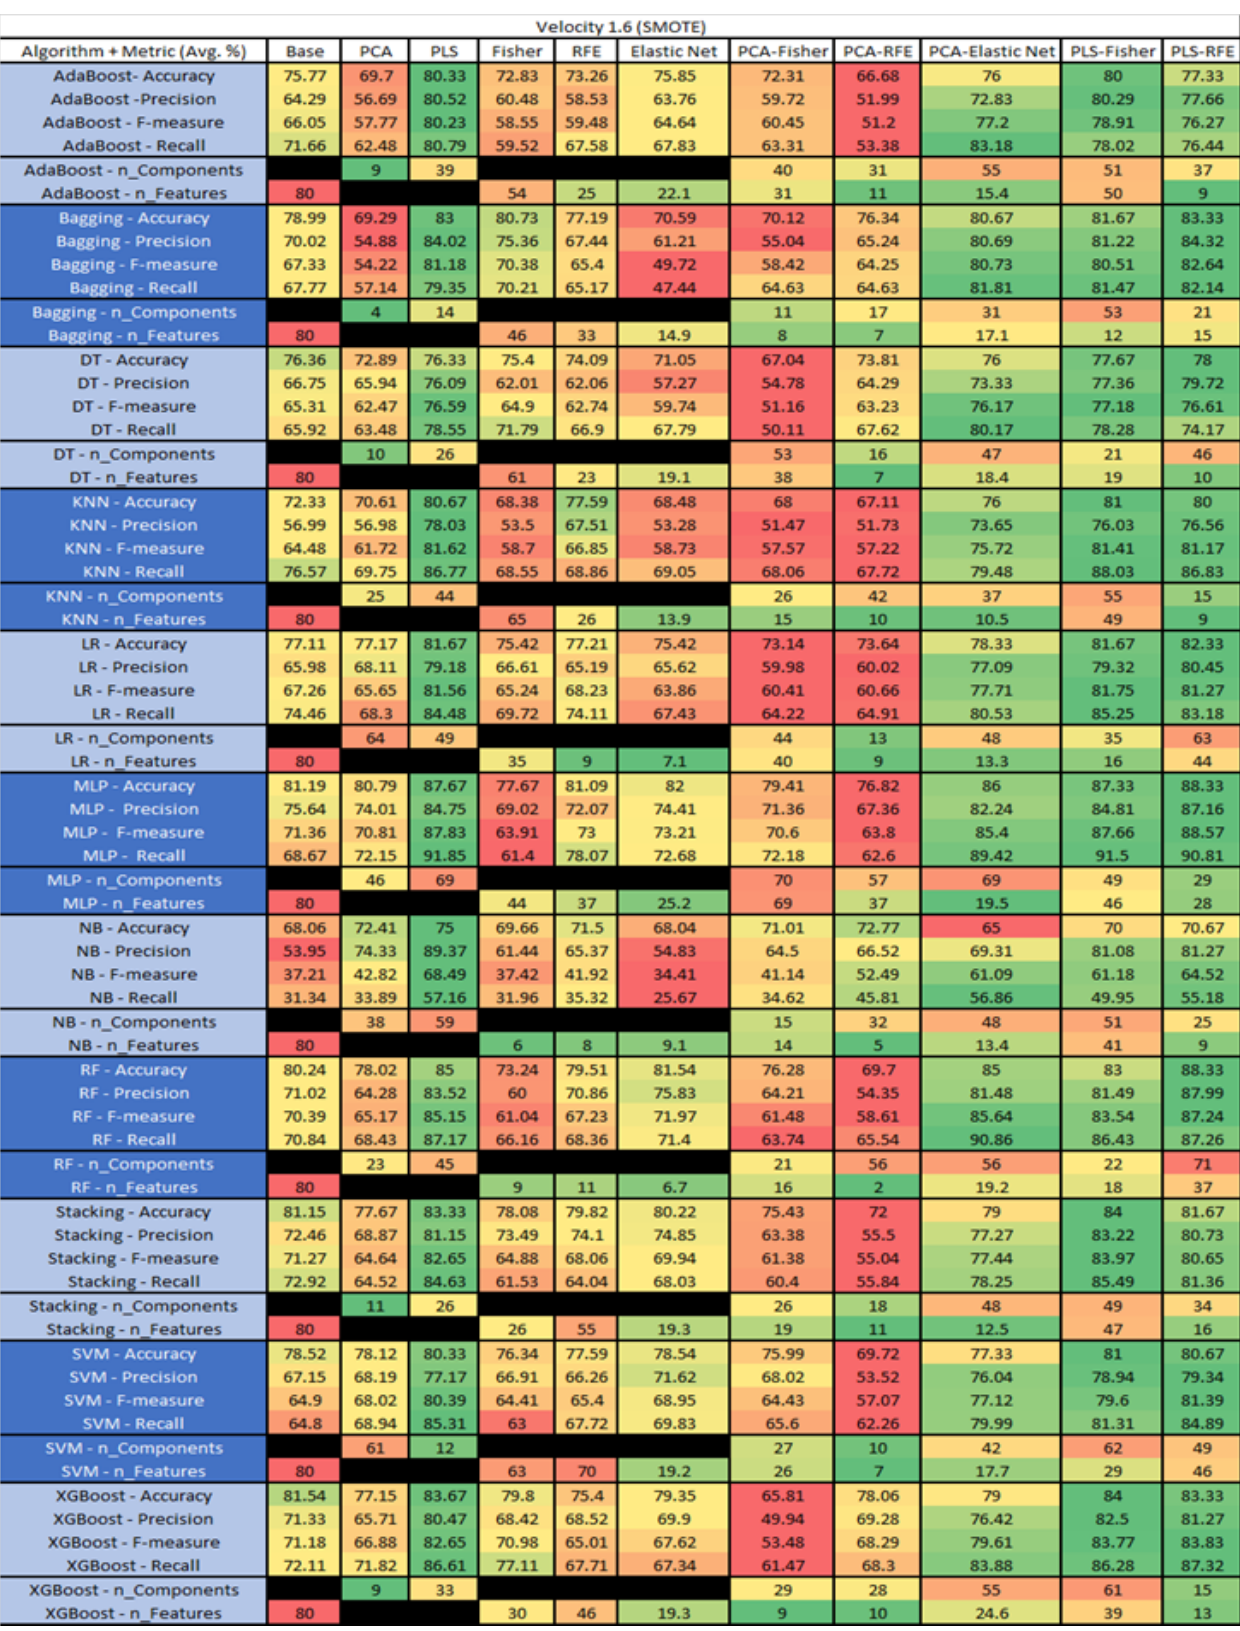
Figure 55. Velocity 1.6 SMOTE PROMISE Results Data